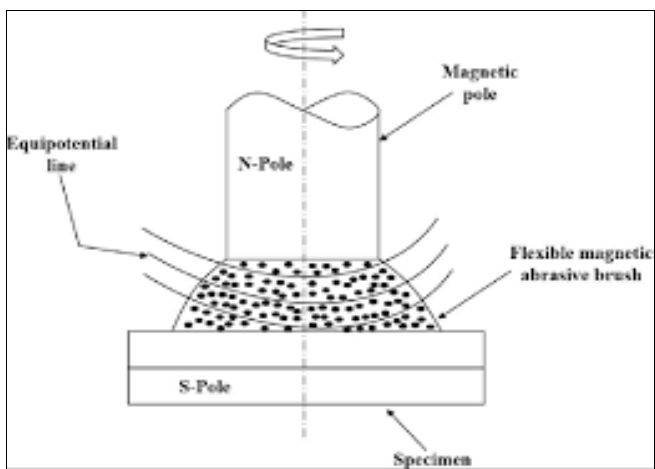
Fig .1. Principle of Magnetic Abrasive Finishing Process [6].